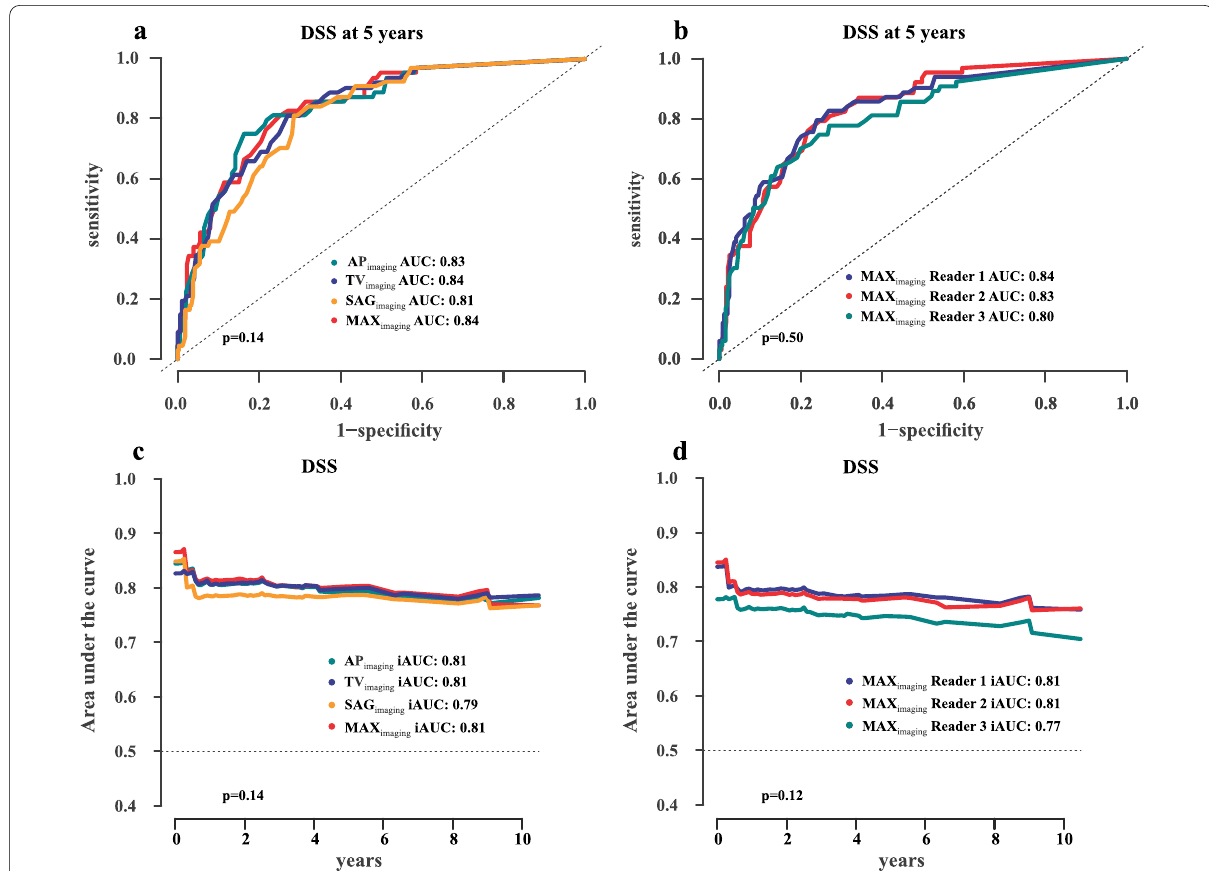
Fig. 3 Time‑dependent receiver operating characteristic curves (tdROC) at 5 years after diagnosis ( a , b ) and integral of area under the time‑dependent ROC curve (iAUC) for 10 years after diagnosis ( c , d ) for predicting disease‑specific survival (DSS) based on the MRI‑derived tumor size measurements ( a , c ) and for MAX imaging for the three readers ( b , d ). All tumor measurements yielded high and similar areas under the tdROC curves (AUC 0.81–0.84; p 0.14) ( a ) and iAUC (iAUC 0.79–0.81; p 0.14) ( c ) for predicting DSS. MAX imaging for the three readers yielded similarly = = = = high areas under the tdROC curves (AUC 0.80–0.84; p 0.50) ( b ) and iAUC (iAUC 0.77–0.81; p 0.12) ( d ) for predicting = = = =